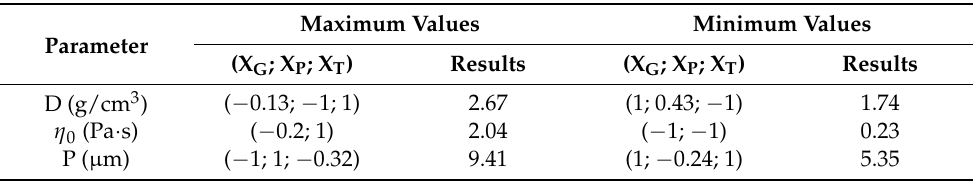
Table 4. Operational variables values in the processing of Ti sponges to obtain maximum and minimum values of the dependent